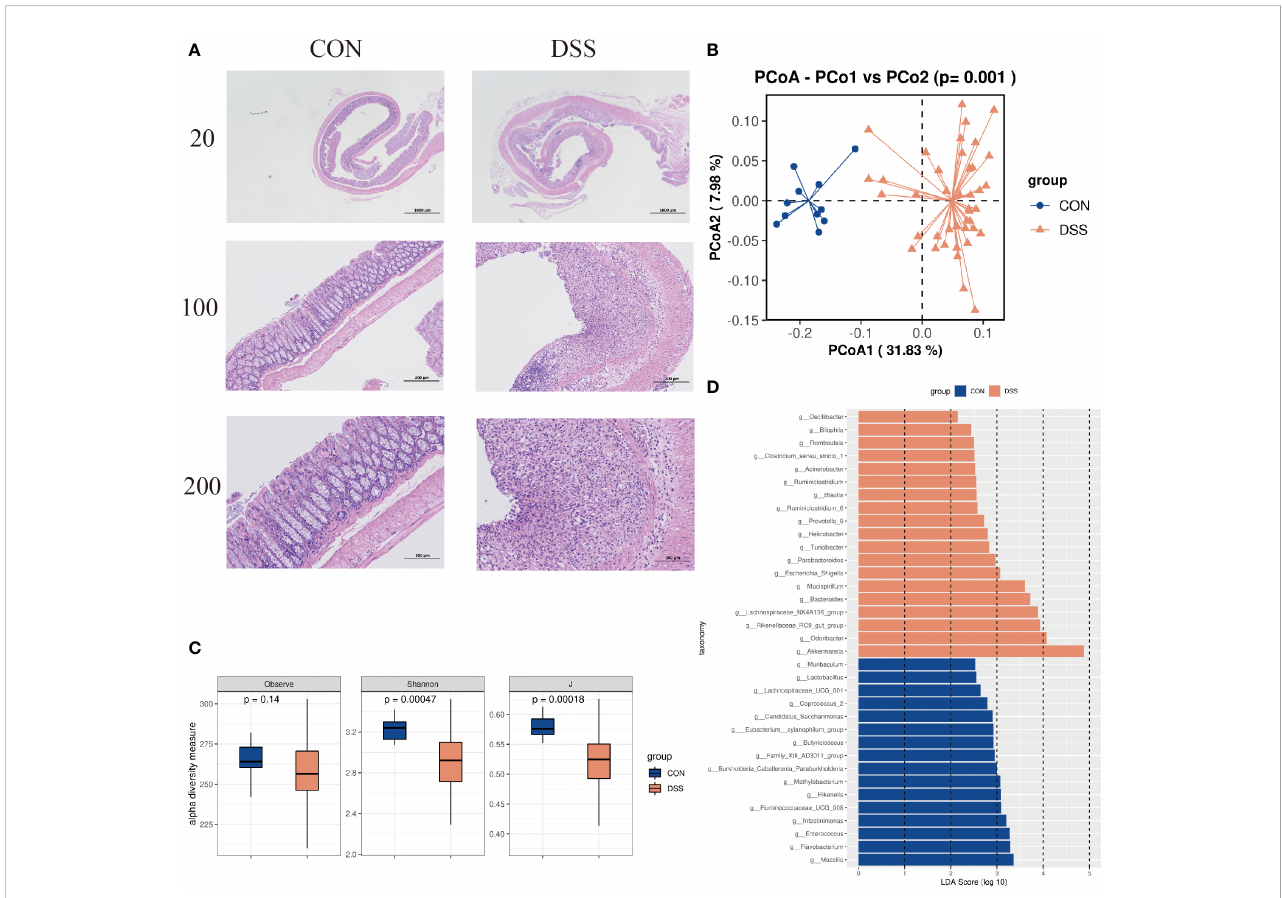
FIGURE 3 (A) HE dyeing experiment pictures. (B) Bacterial beta diversity. Principal Coordinates Analysis based on Bray-Curtis distances between the gut microbiota pro fi les of mice from the two groups. (C) Alpha diversity based on species richness, the Shannon diversity index, and the Inverse Simpson diversity index (J) in DSS and CON. (D) Signi fi cantly enriched bacterial taxa in the different groups as determined by LEfSe analysis (LDA sore